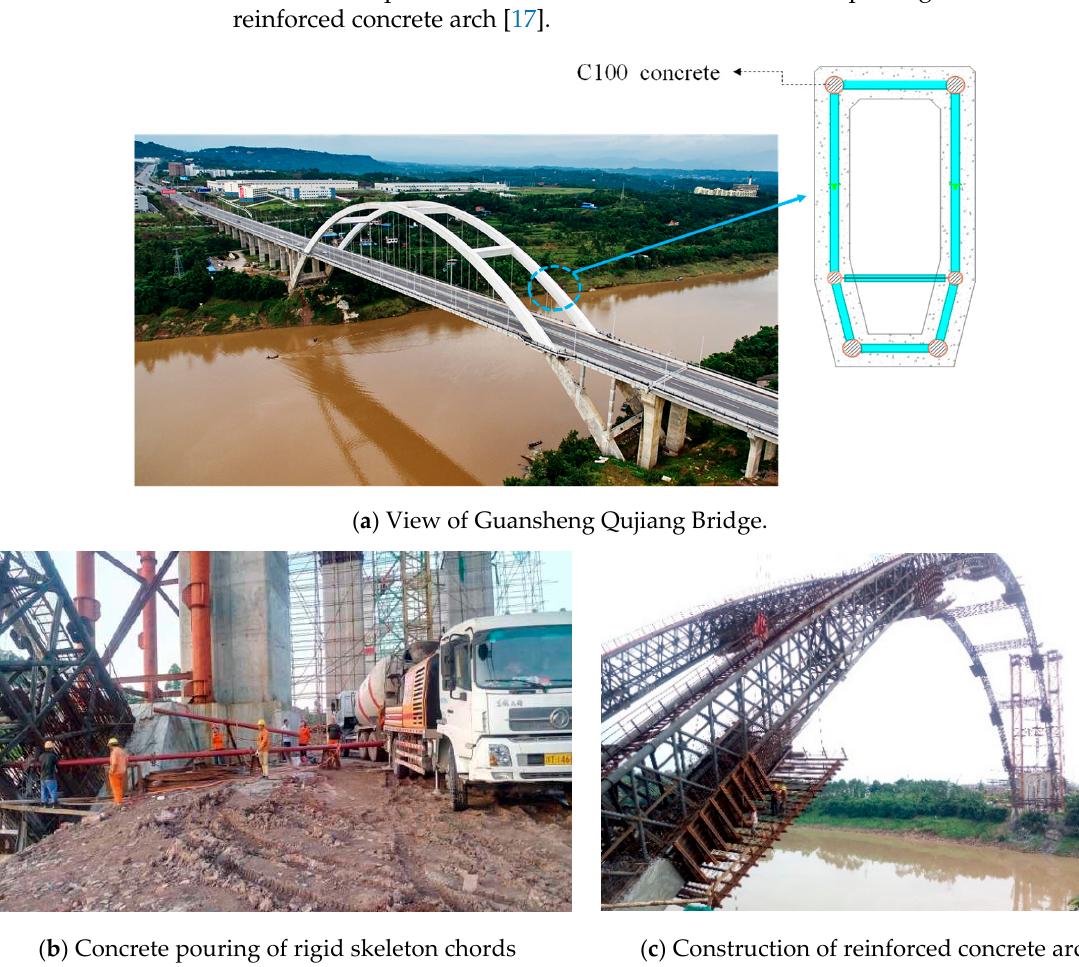
Figure 1. Guansheng Qujiang Bridge, and the steel tube in the rigid skeleton filled with C100 con- crete.